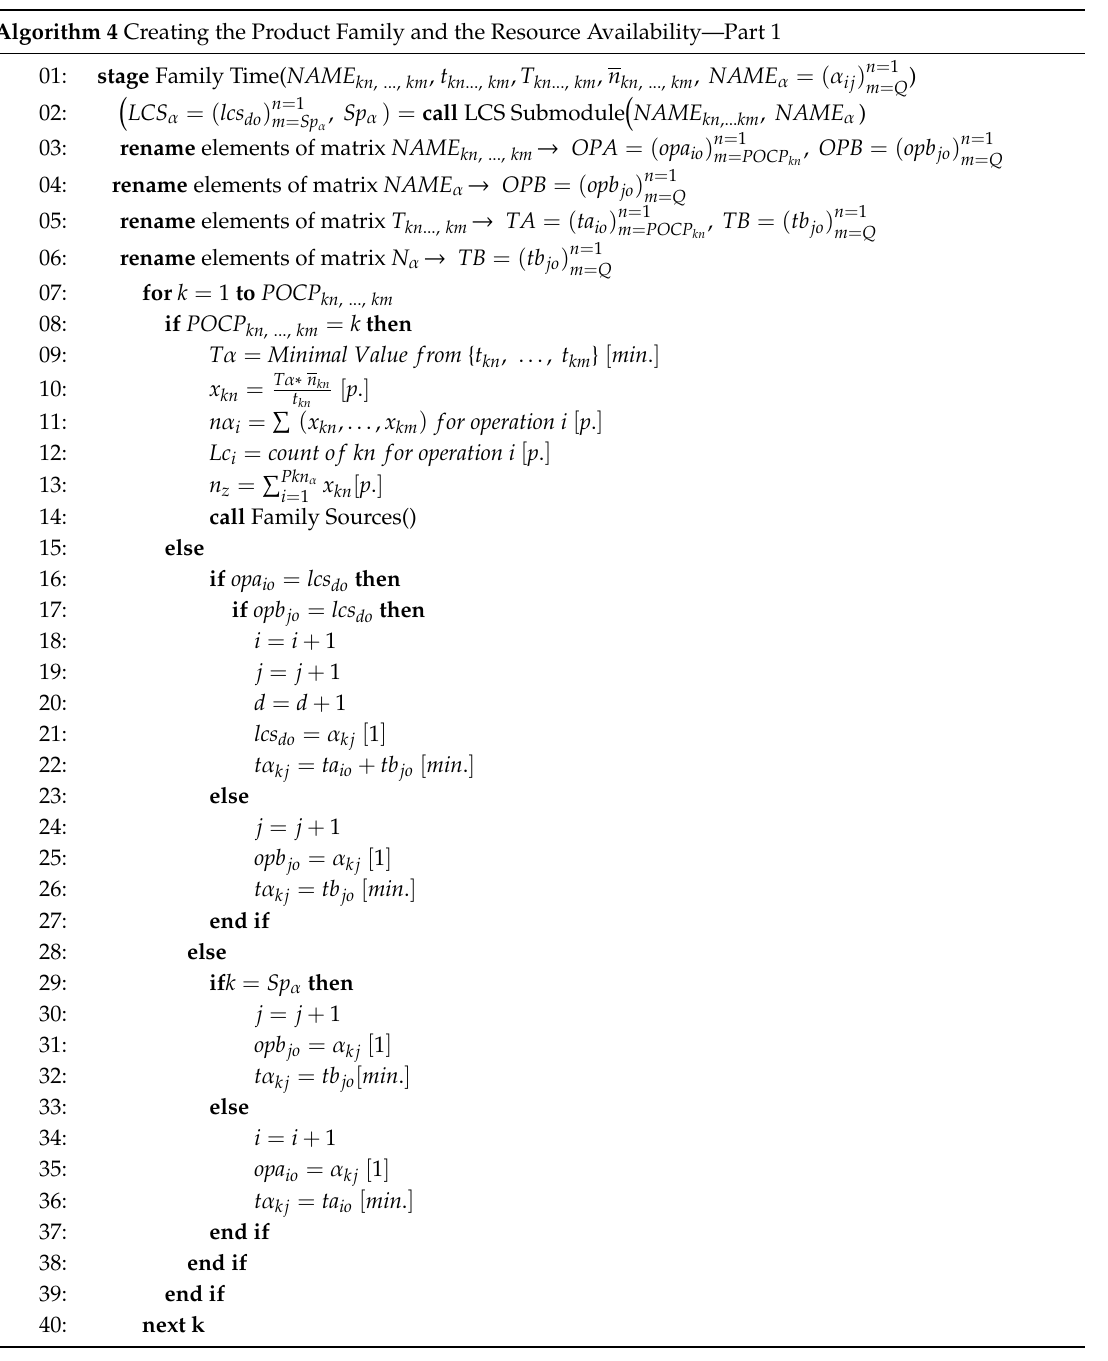
Algorithm 4 Creating the Product Family and the Resource Availability—Part